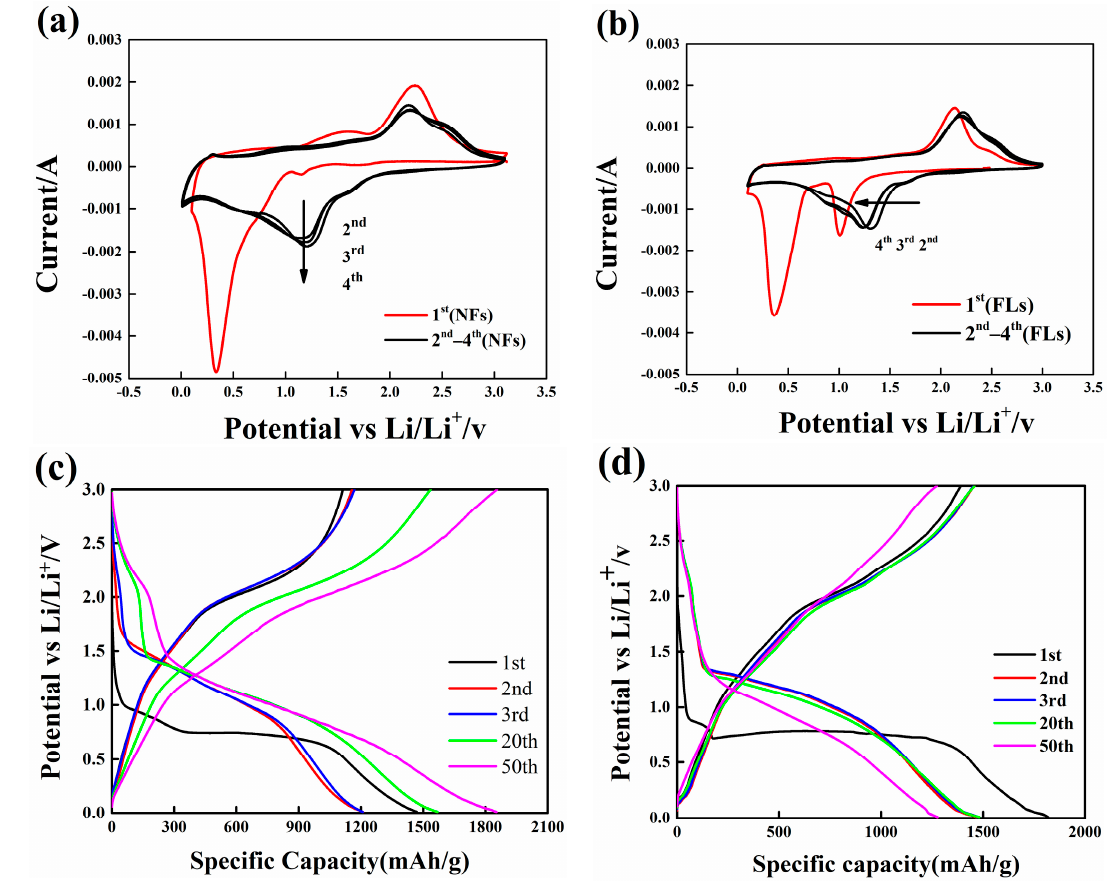
Figure 4. CV curves for the first four cycles of CoO-NFs ( a ) and CoO-FLs ( b ) at a scan rate of 0.2 mV s − 1 ; Discharge and charge voltage profiles of the CoO-NFs ( c ) and CoO-FLs ( d ) at a current density of 100 mA g − 1 .